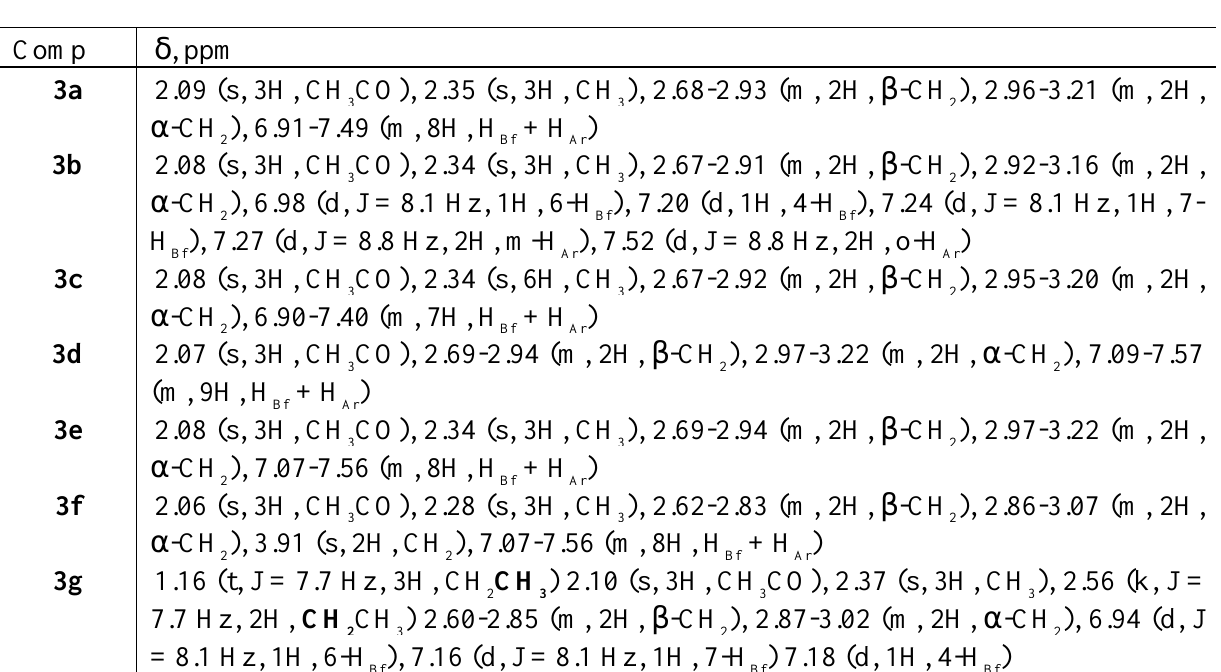
Table 4. 1 H-NMR spectra of compounds 3a - g